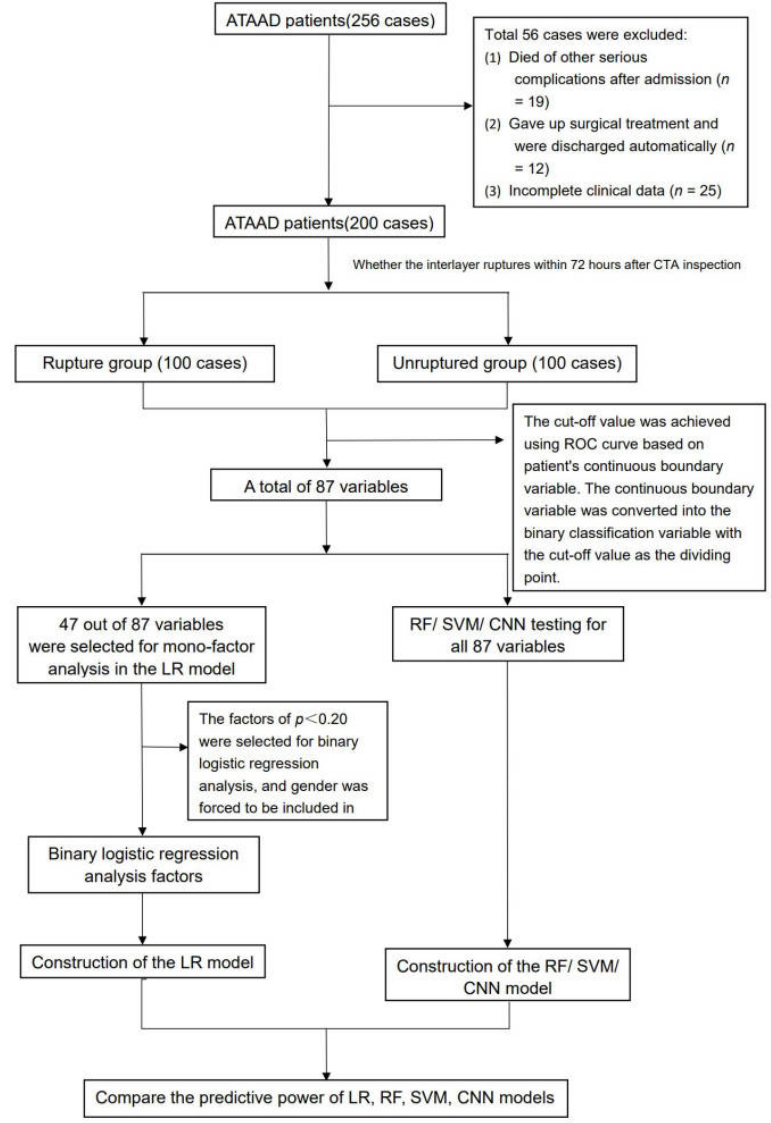
Figure 1. An overview of the flow through the study.